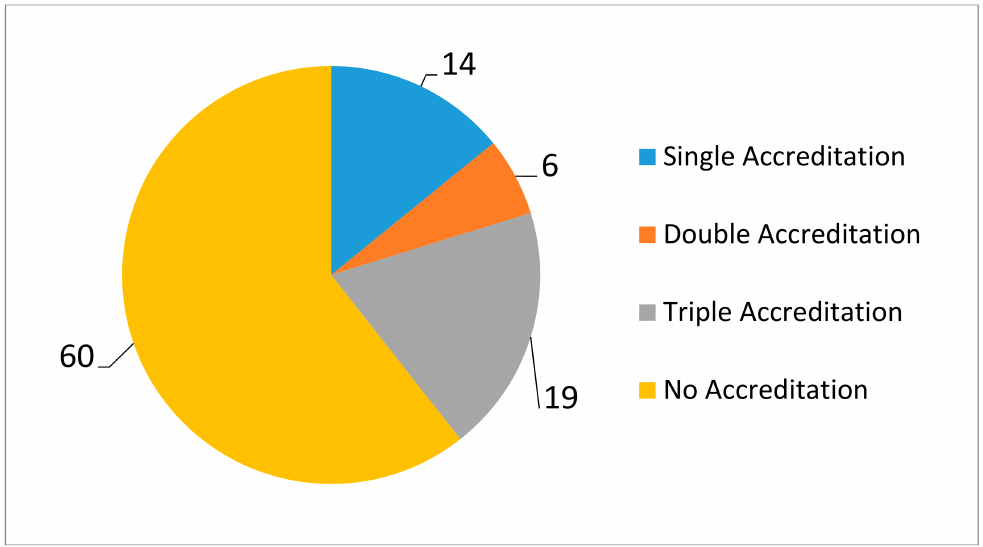
Figure 1. Number of